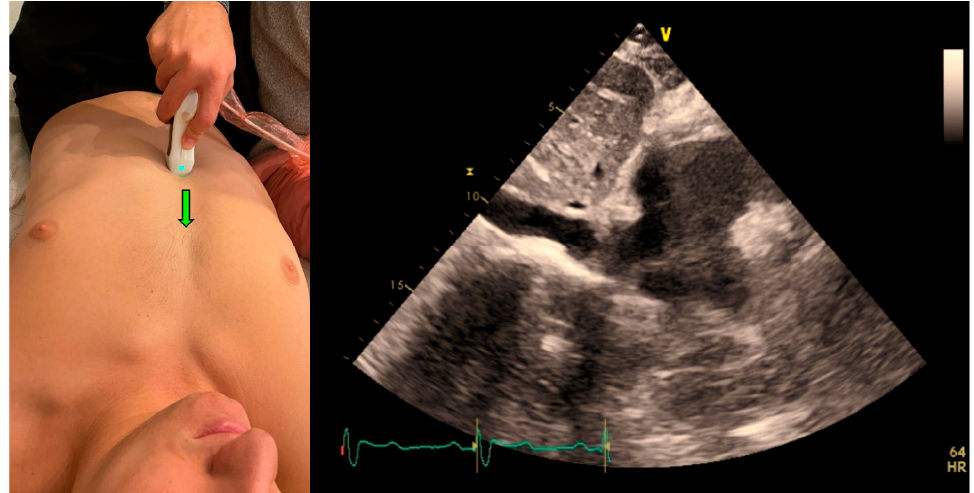
Figure 3. Acquisition (probe point—green arrow) and anatomy of IVC View.